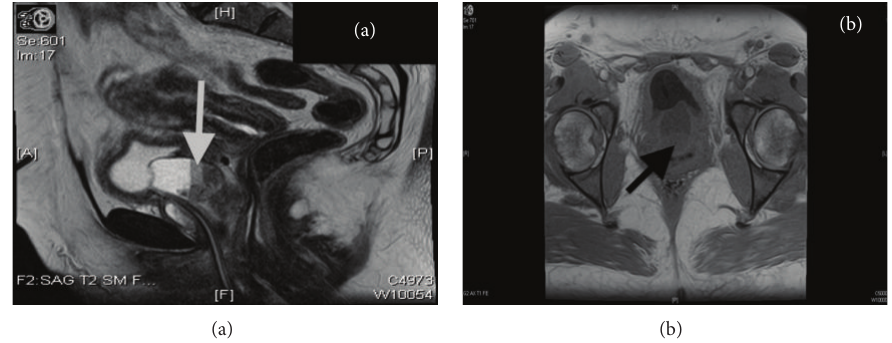
Figure 1: Magnetic resonance imaging shows 4.4 cm × 3.2 cm × 3.6 cm nodular enhancing mass concerning malignancy.